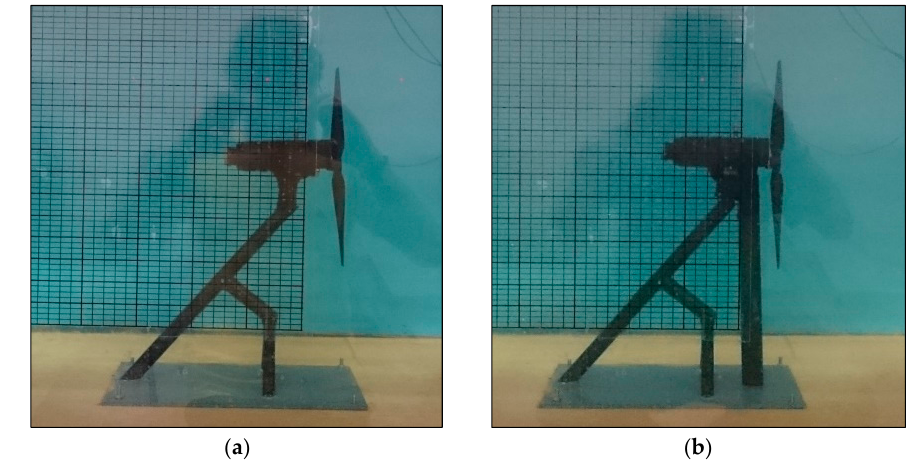
Figure 4. Tidal turbine support structure model S1 ( a ); Tidal turbine support structure model S2 ( b ).